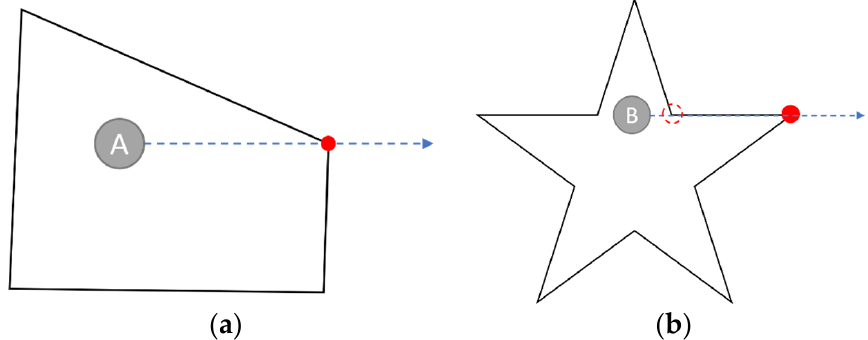
Algorithm 2 Function is PointWithinPolygon() Figure 16. The ( a )common terminal case ( b ) line segment case of polygon intersection.